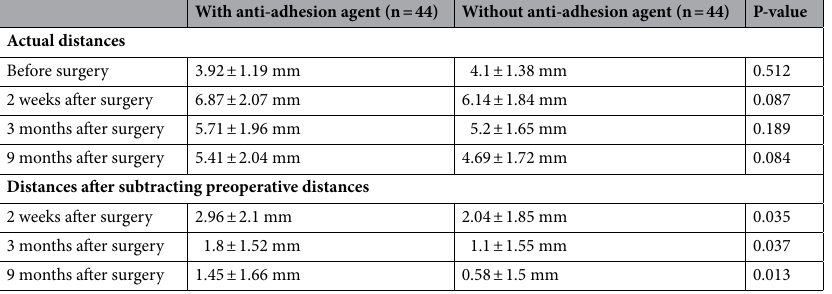
With anti-adhesion agent (n = 44) Without anti-adhesion agent (n = 44) P-value